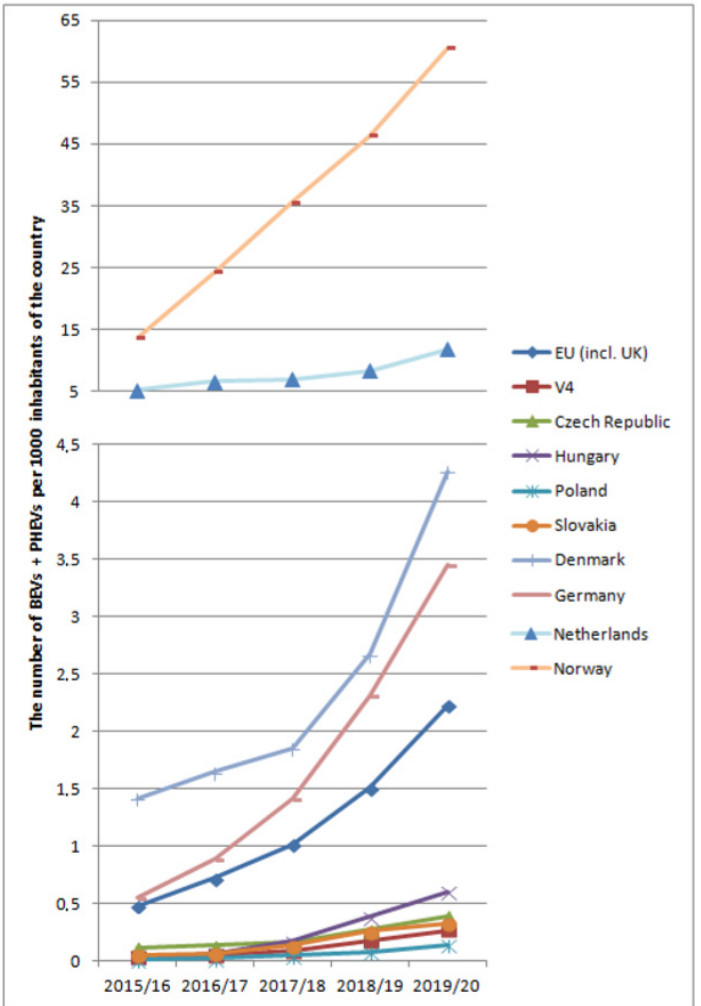
Figure 4. The development of the parameter E p (the total number of battery electric vehicles plus plug-in hybrid electric vehicles per 1000 inhabitants of the country).